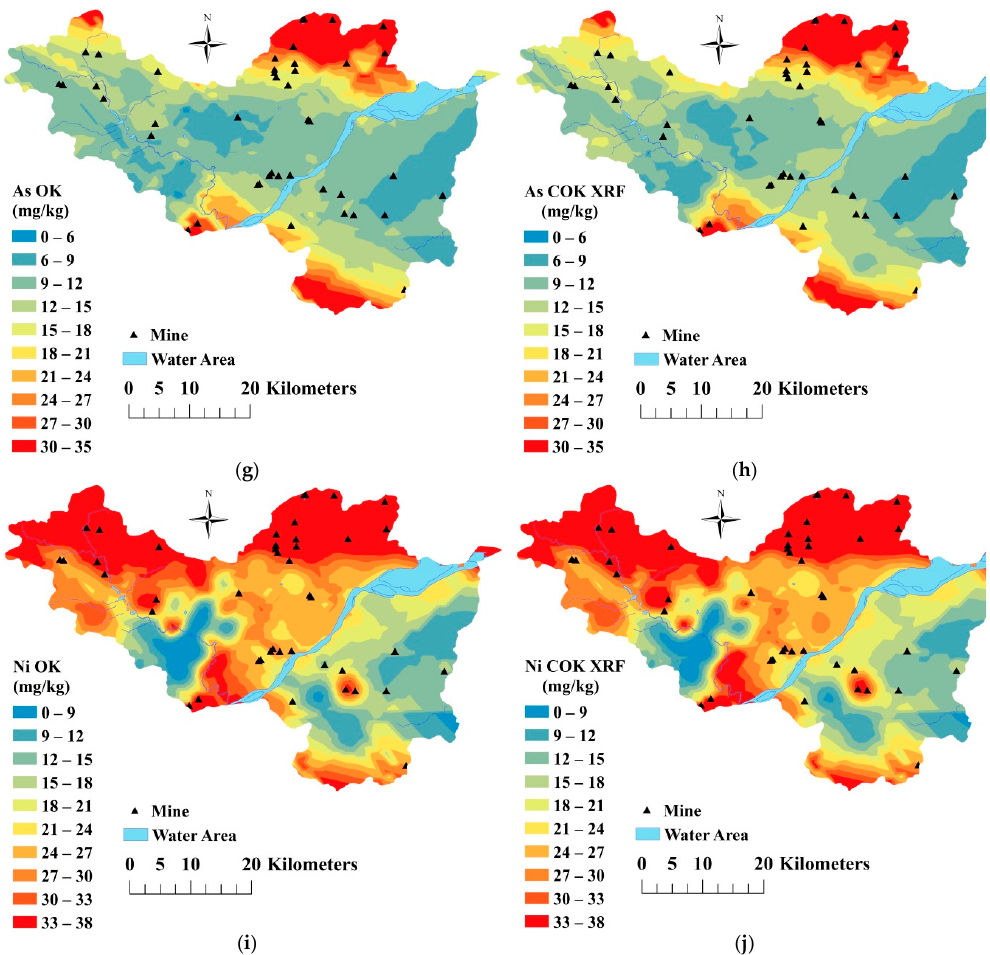
Figure 3. Spatial distribution of heavy metals content determined by ordinary kriging (OK): (( a ) Cr, ( c ) Pb, ( e ) Cd, ( g ) As, ( i ) Ni) and co-ordinary kriging (COK): (( b ) Cr, ( d ) Pb, ( f ) Cd, ( h ) As, ( j ) Ni).